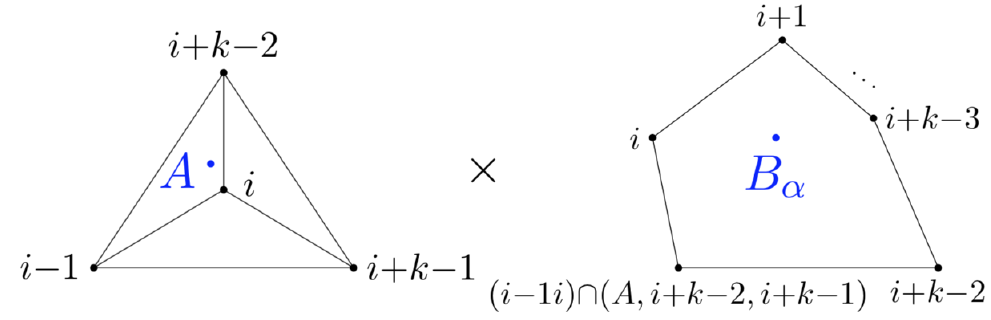
Figure 13 . n -point geometry for the intersecting